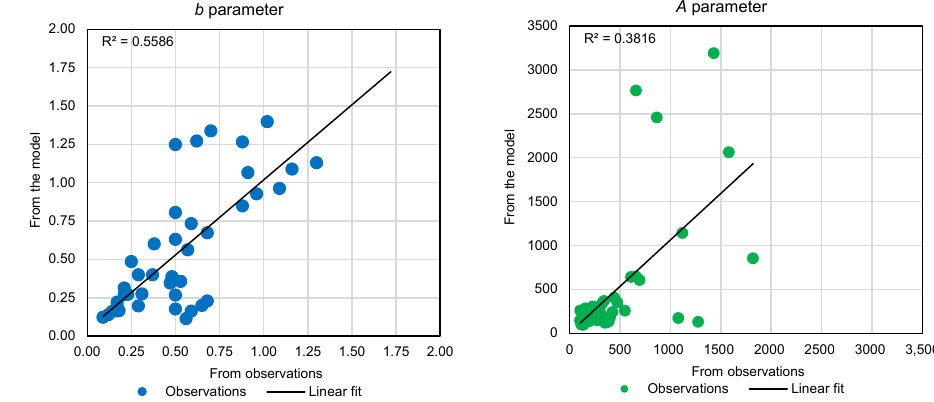
Figure 3. Estimates of A and b parameters (Eq. 10) from modelled and observed population